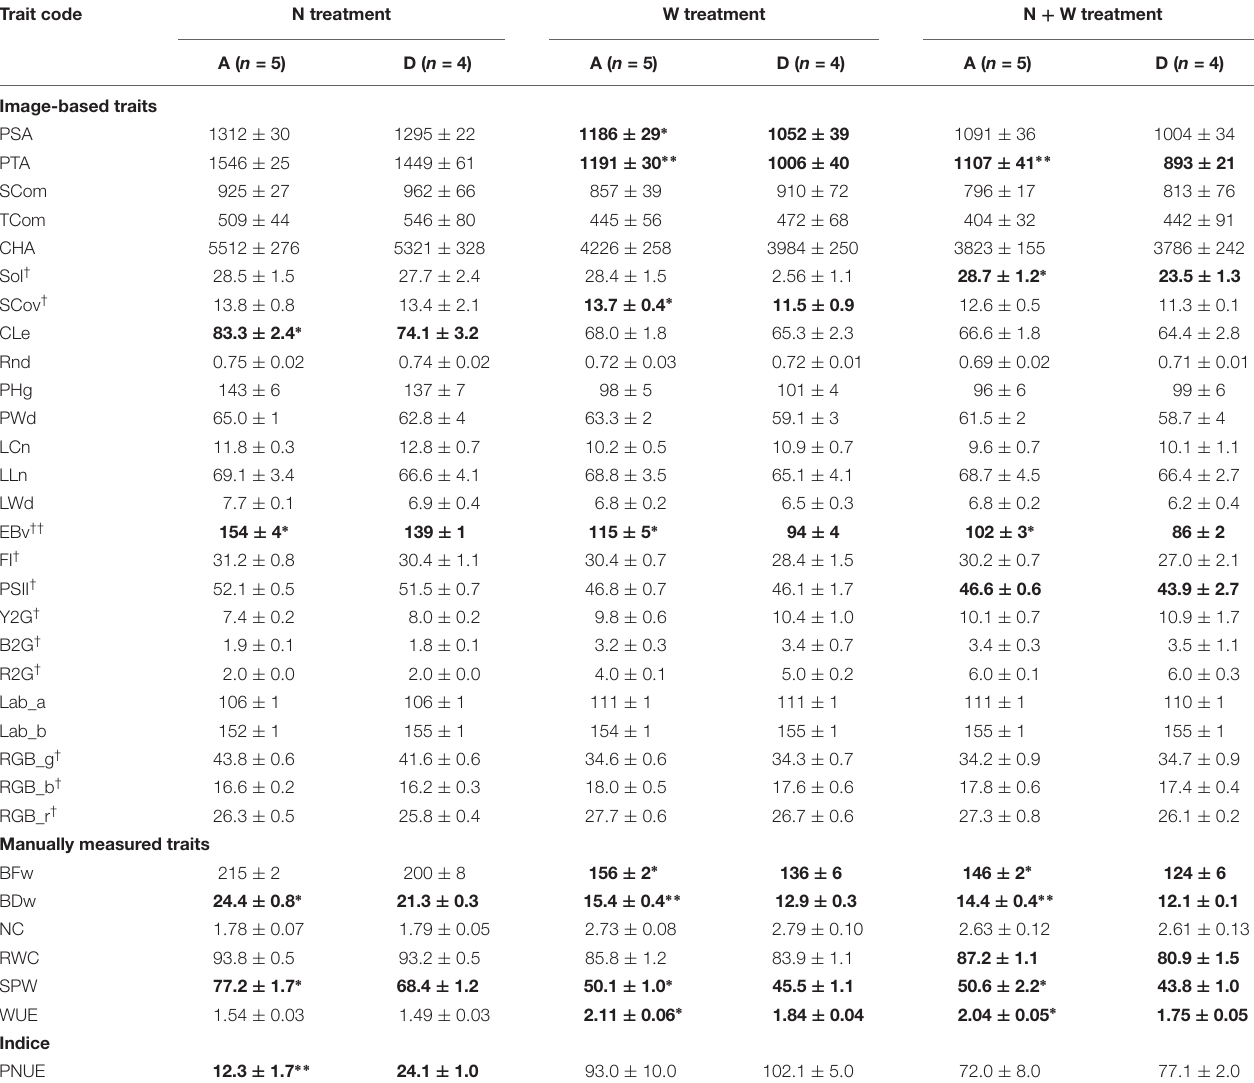
TABLE 3 | Comparison of best (A) and worst (D) inbred lines based on their productivity and tolerance under stress (A, high productivity and high tolerance; D, low productivity and low tolerance). Trait code N treatment W